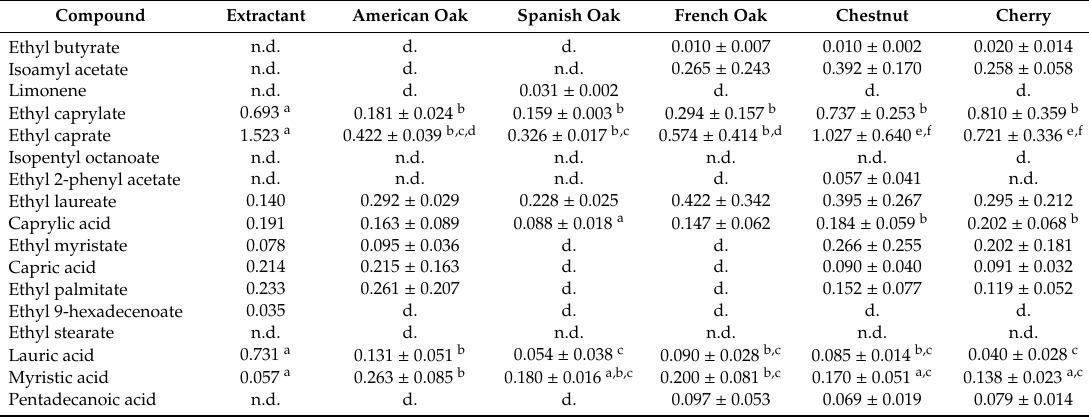
Table 8. Relative area values of volatile compounds determined by Stir-bar Sorptive